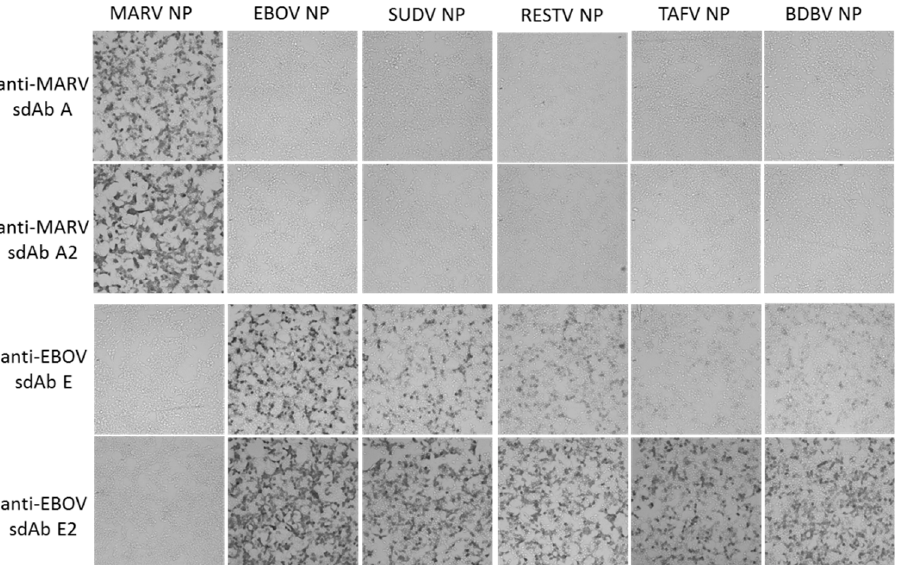
Figure 2. HEK293T cells were transiently transfected with various NP expression plasmids indicated at the top of the panels. At 24 h post-transfection, the cells were probed with 10 nM of the various sdAb–APEX2 fusion proteins indicated to the left of the panels, developed with 3, 3’-diaminobenzidine (DAB) for 1 min and visualized with light microscopy at 10× magnification.